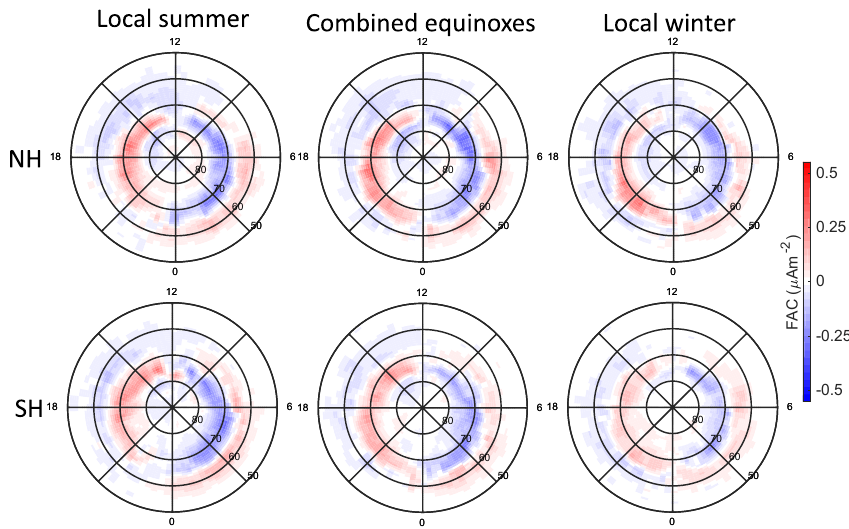
Figure 1. Average distribution of auroral field-aligned currents in the two hemispheres for different seasons. Red colors represent upward currents and blue downward.